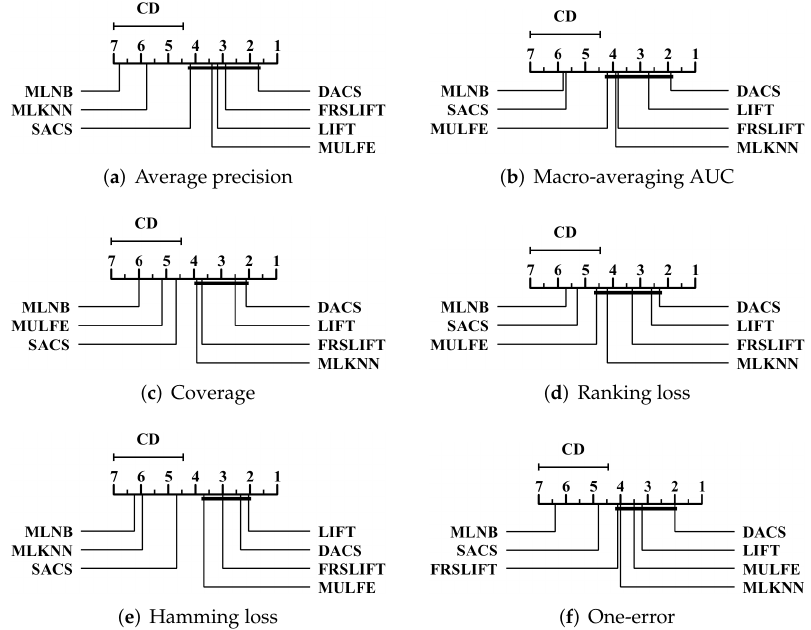
Figure 3. Comparison of DEPT (control algorithms) against other compared algorithms with the Bonferroni–Dunn test.